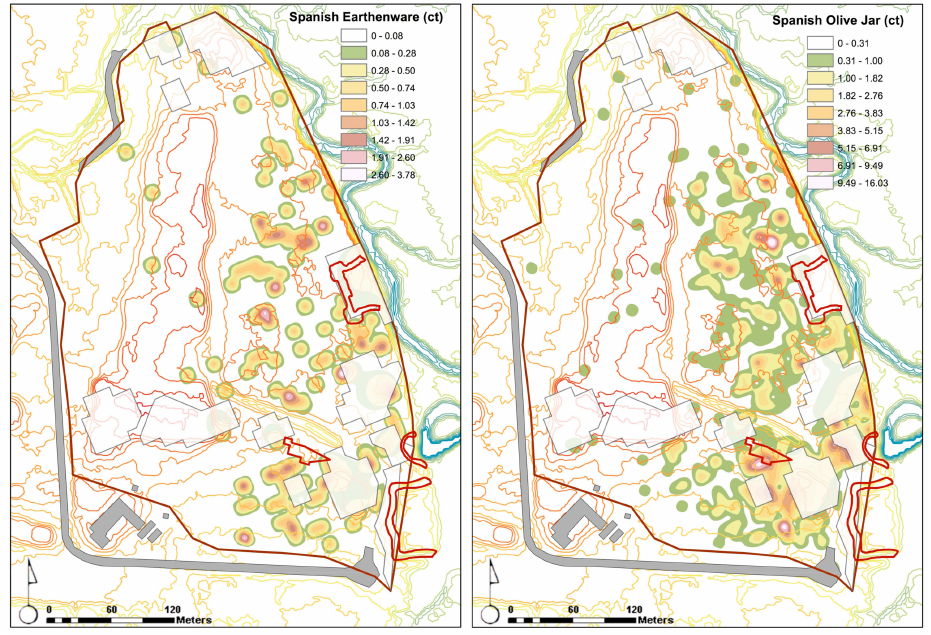
Figure 16. The distribution of Spanish period earthenware ( left ) and olive jar ( right ) ceramics recorded through a shovel test survey. Areas whited-out were not shovel tested. Contour spacing is 1 m. Contours are based on the LiDAR dataset and use the NAD 1983 and NAV 1988 horizontal and vertical datum,